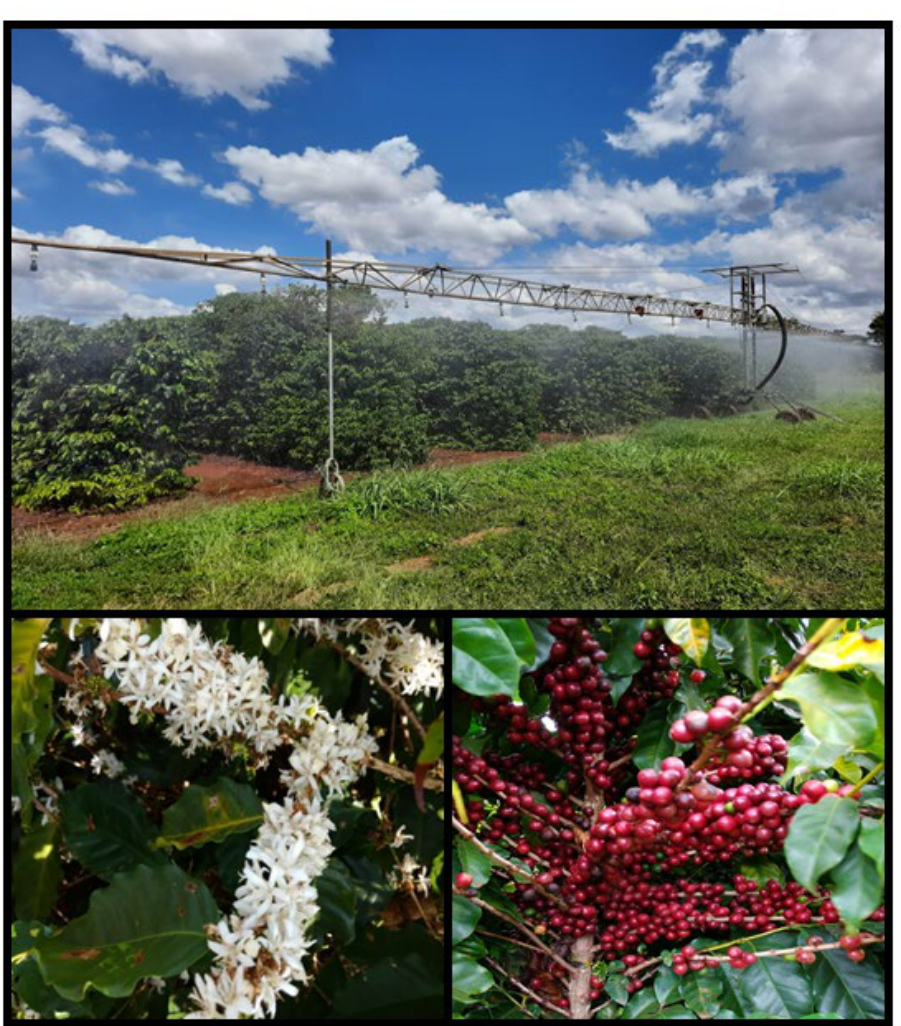
Figure 9. Irrigation system with controlled stress, uniform flowering and cherry grains. A portable open–flow gas exchange system (IRGA–LI-6400XT; LI–COR Inc., Lincoln, NE, USA) was used for gas exchange analysis. Evaluations were performed on three plants per plot, on the youngest fully expanded leaves of plagiotropic branches, in the middle third of the plants. Gas exchange was determined with a CO 2 concentration of 400 ppm, a photosynthetic photon flux density of 1000 µ mol m − 2 s − 1 and relative humidity between 40% and 60%. The evaluations were performed in the morning, between 8 am and 11 am; this period of evaluation was determined by a daily photosynthesis curve (Figure